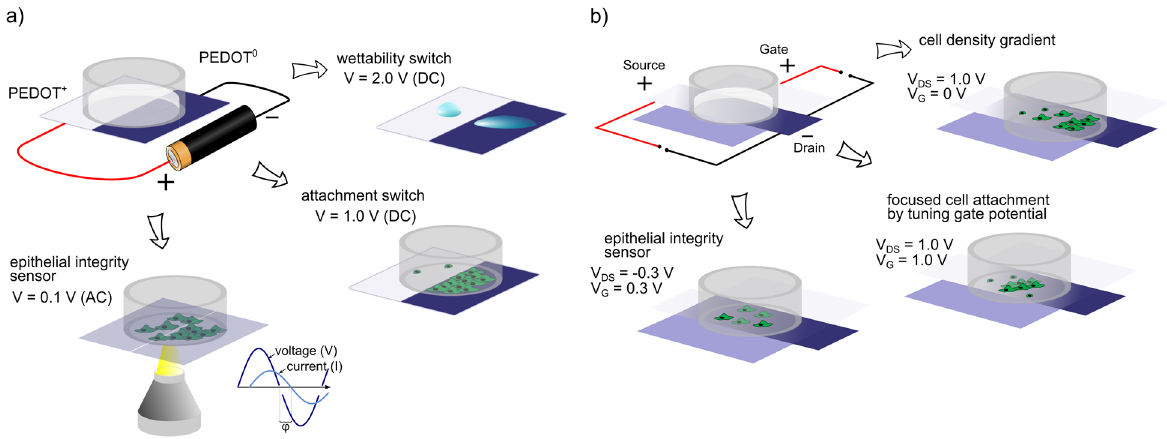
Figure 3. Organic bioelectronics used for electrochemical control of surface energy. ( a ) A two-electrode surface switch is used to display oxidized or reduced surfaces upon electrochemical switching. Using the two-electrode switch, cell attachment can be controlled, since cells tend to grow on the reduced surface but not on the oxidized surface. Also, applying an alternating sinusoidal potential, a transparent two-electrode sensor can be created by monitoring the phase delay of the measured current. This sensor can be used to monitor epithelial barrier formation and disruption. Simultaneous optical and electronic measurements can be performed as the sensor is fully transparent; ( b ) An organic electrochemical transistor (OECT) is created by adding a gate electrode to a conductive channel between source and drain electrodes. Applying a constant potential over the channel, cell density gradients can be created due to the cells preference for a certain surface redox state. Tuning the gate potential, cellular attachment can be focused to a narrow area along the channel of the OECT. By pulsing the gate potential and measuring current transients, the conductivity of the channel can be determined. Thus, the OECT can be applied as sensor for epithelial integrity as